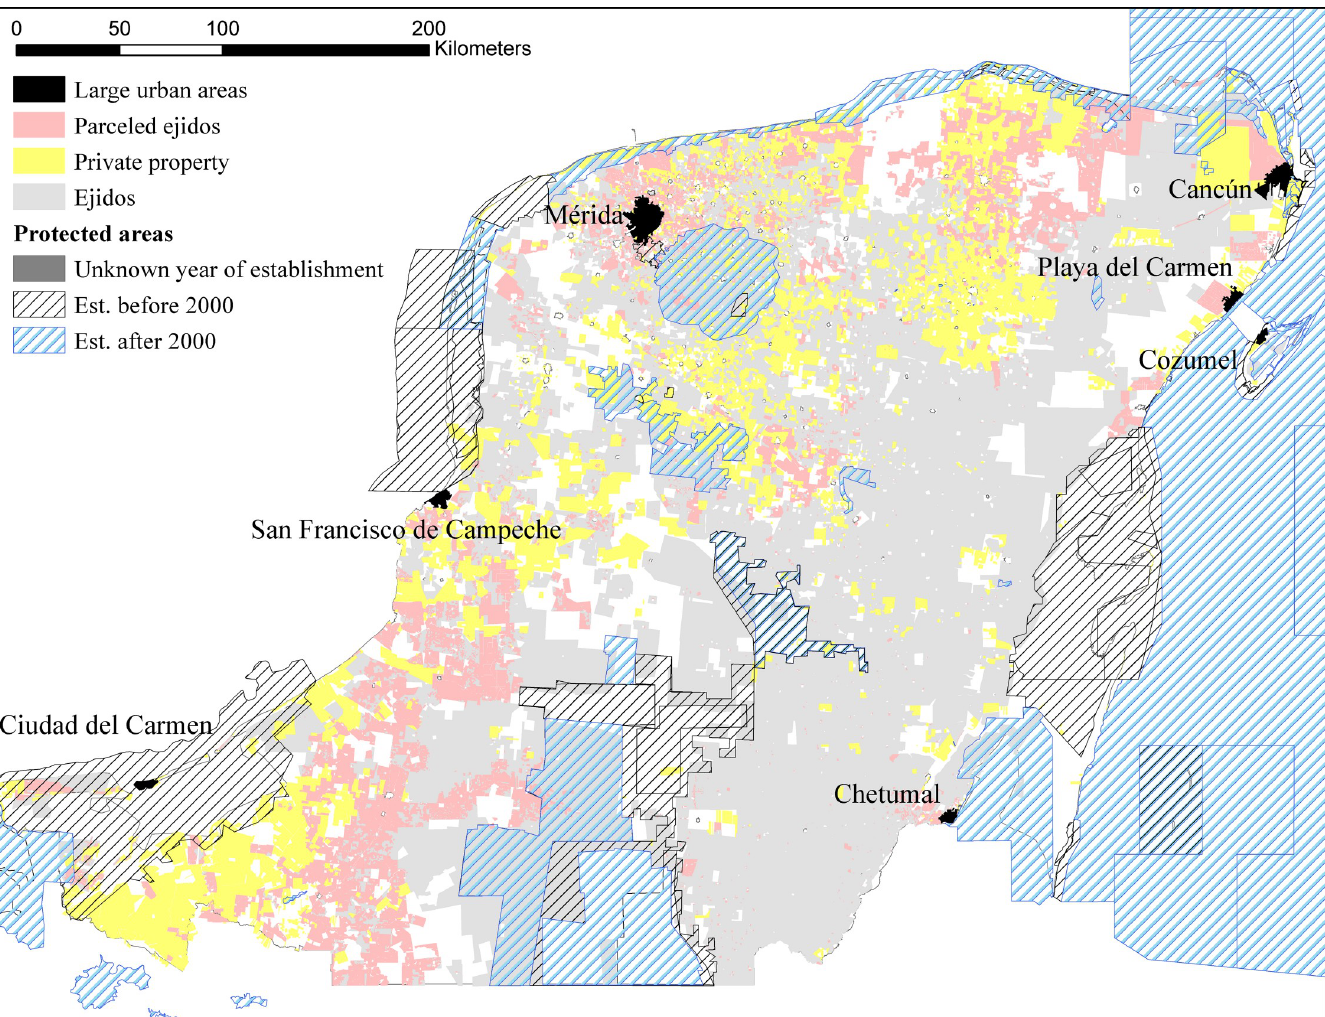
Fig 2. Distribution of the land tenure types within our study area. The areas with missing tenure information are in white and urban areas-in